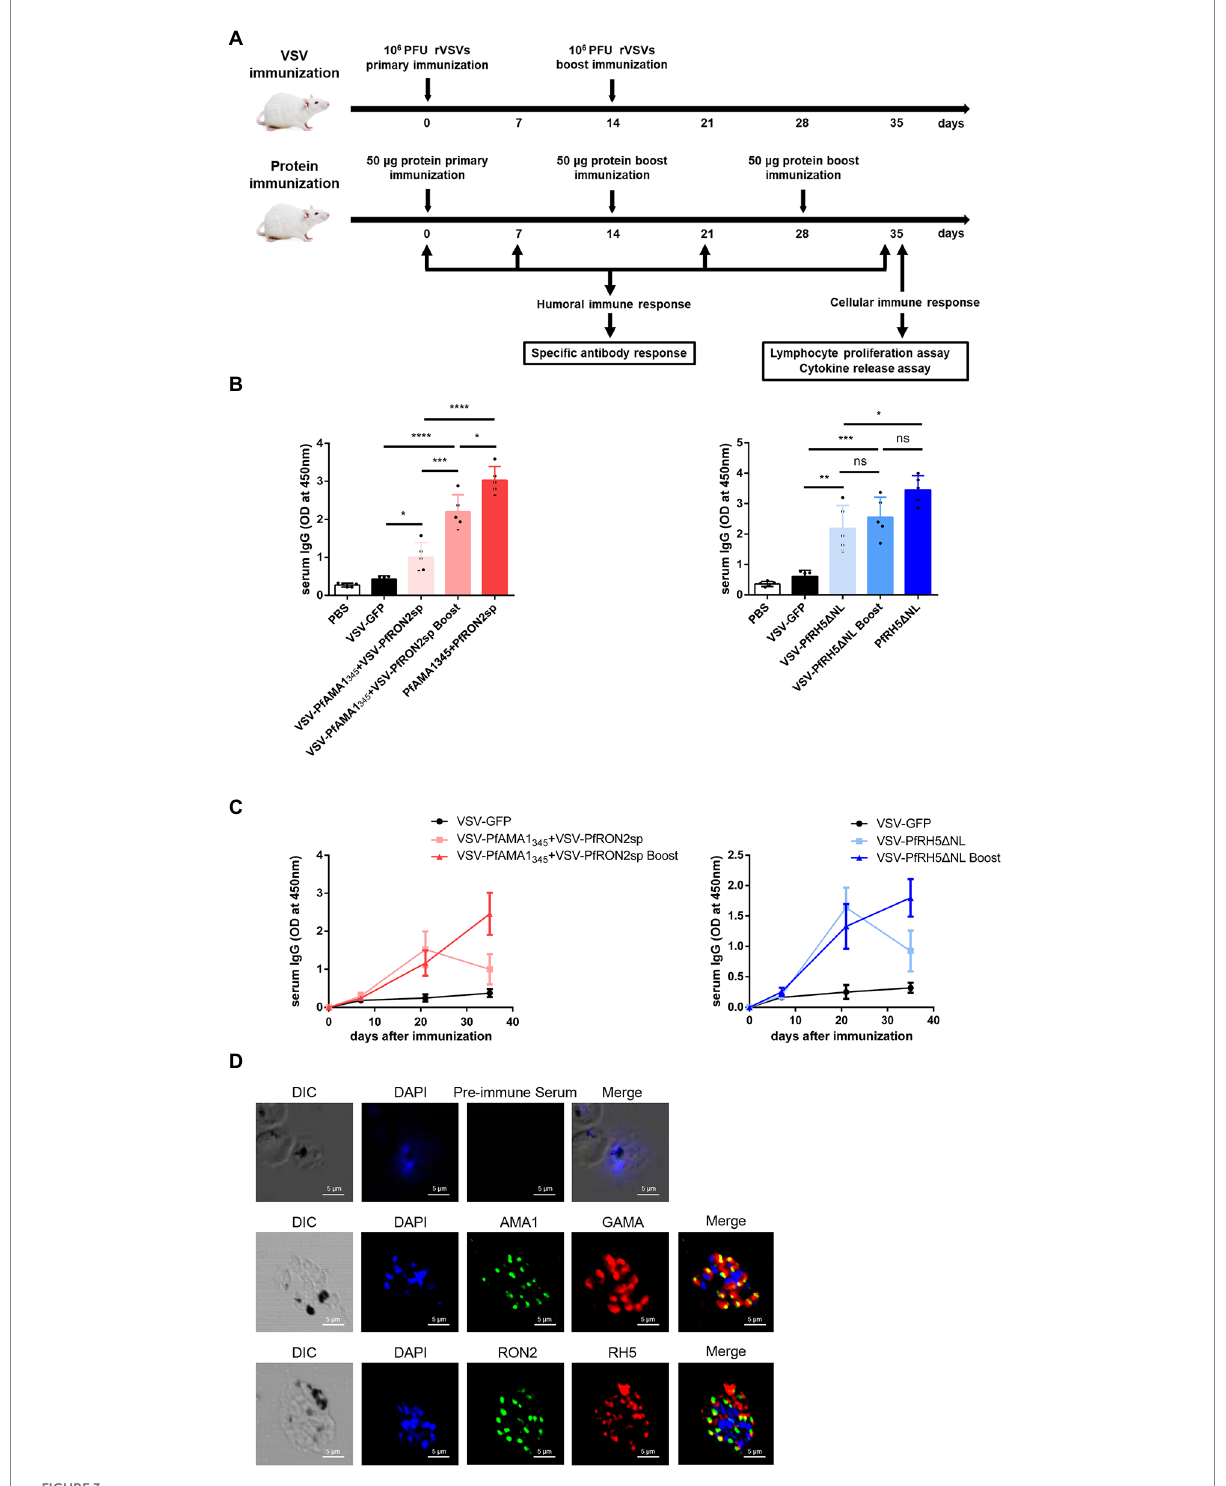
FIGURE 3 Antigen-specific humoral immune responses induced by rVSVs. (A) Schematic representation of animal vaccination and detection strategies. BALB/c mice (n = 5 per group) were intranasally immunized with 25 μ l of 10 6 PFU VSV-PfAMA1 345 + VSV-PfRON2sp (VSV-PfAMA1 345 and VSV- PfRON2sp mixture) or VSV-PfRH5 Δ NL as single or prime-boost vaccination. The mice were intraperitoneally injected with 50 μ g PfAMA1 345 + PfRON2sp and PfRH5 Δ NL antigens three times at the indicated time points. The immune responses were detected at the indicated time points. (B) Specific IgG titers were analyzed on day 35 after primary immunization with rVSVs single and prime-boost or proteins by ELISA coated with 5 μ g/ml PfAMA1 345 + PfRON2spor PfRH5 Δ NL proteins (peptides). (C) The trend of specific IgG antibodies in mice immunized with